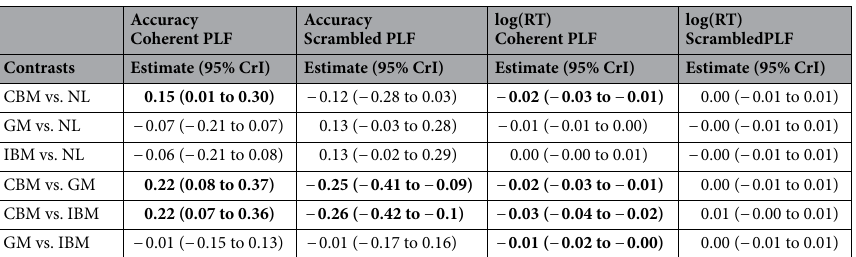
Table 2. Accuracy and RT results for Experiment 2. Cue names are as follows: CBM congruent biological motion, GM general motion, IBM incongruent biological motion, NL no language. Bolded are estimates and credible intervals that did not cross